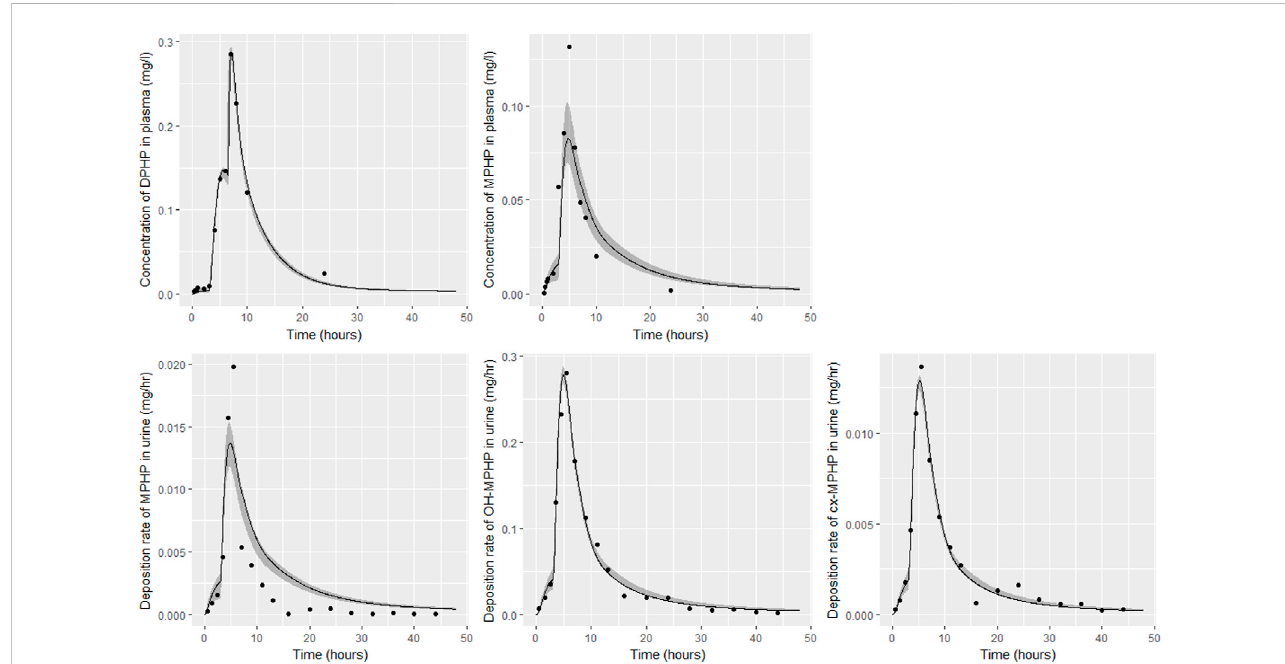
FIGURE 6 Fit ofthe calibrated model to data from individual (A) . Panel (A) DPHP in venous blood (mg/L); (B) MPHP in venous blood (mg/L); (C) rate of depositionof MPHP into the bladder; (D) rate of deposition of OH-MPHP into the bladder; and (E) rate of deposition of cx-MPHP into the bladder. The central estimates indicated in plots correspond to the posterior mode whereas the shaded regions represent 95% intervals for the respective curves.